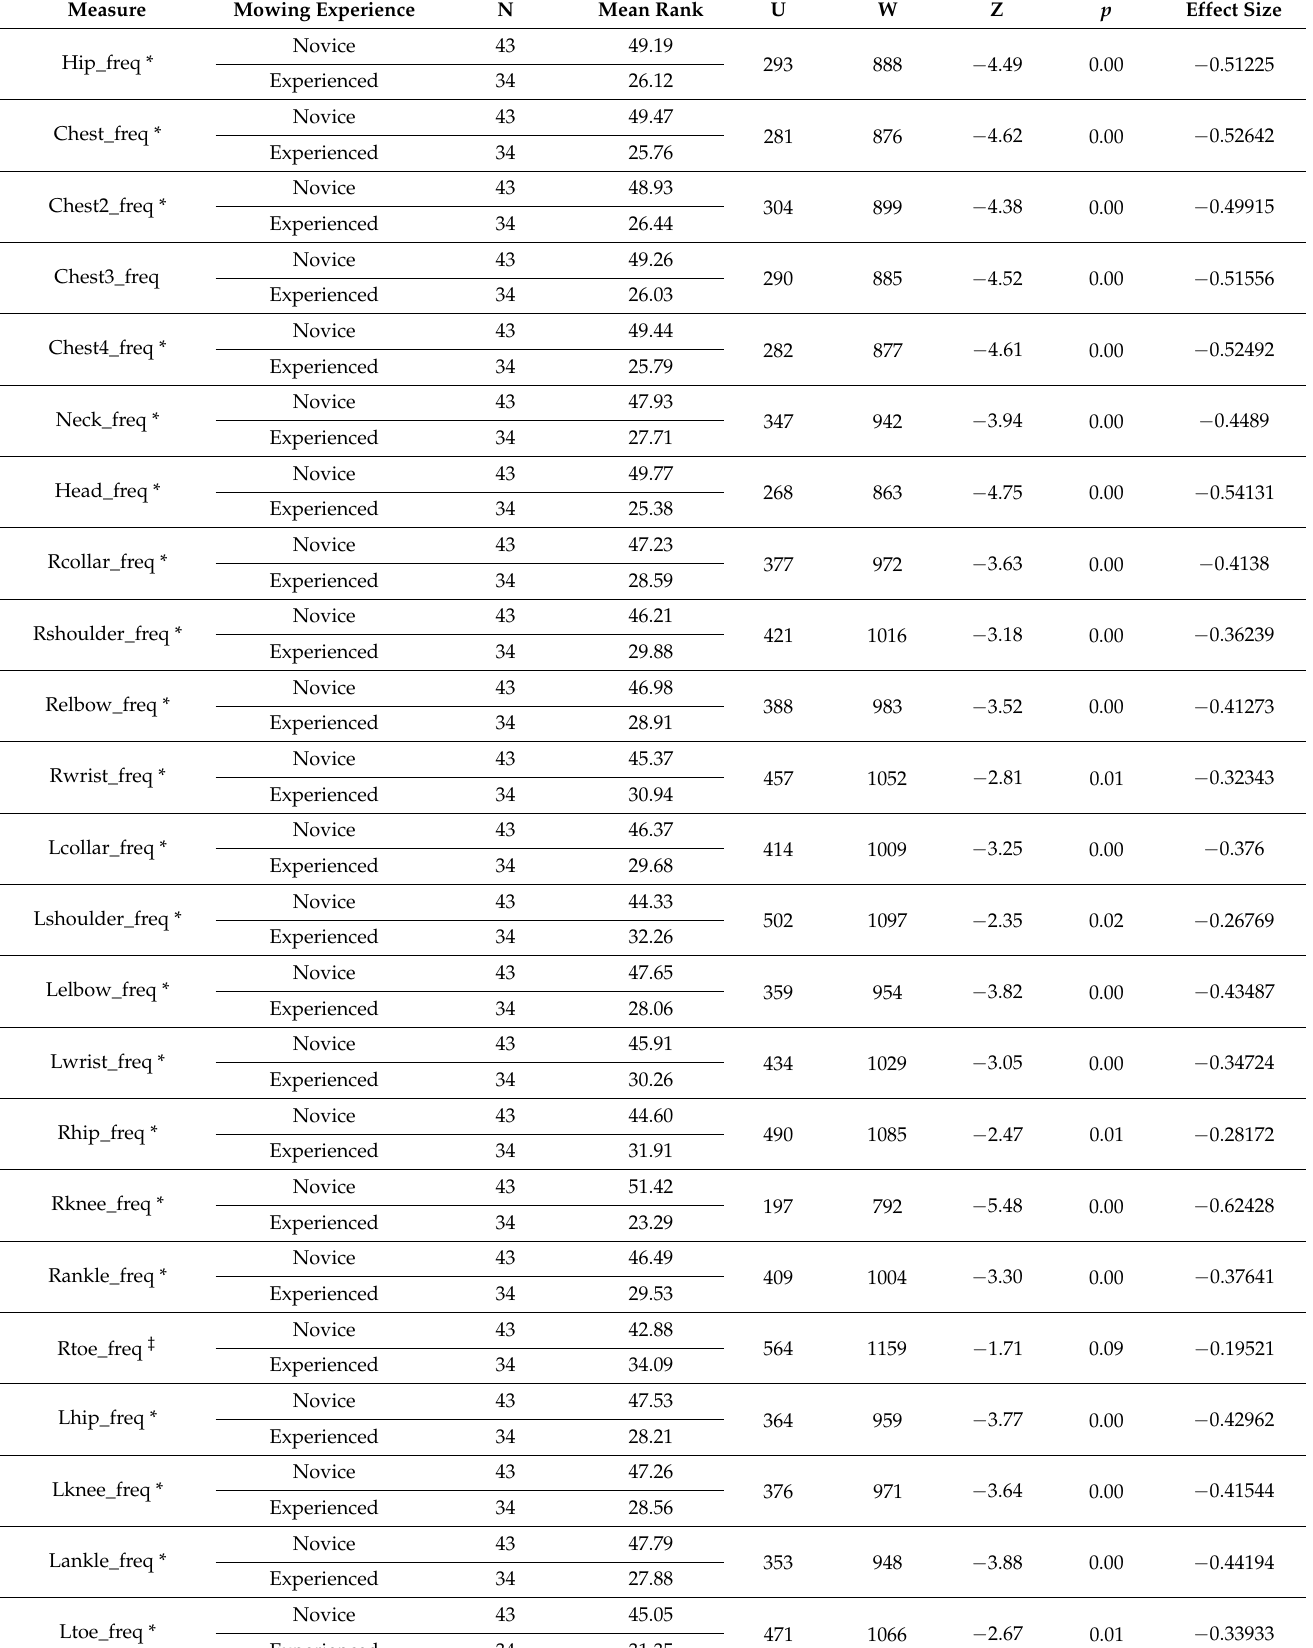
Table 4. Results for Different Mowing Experience (Freq.